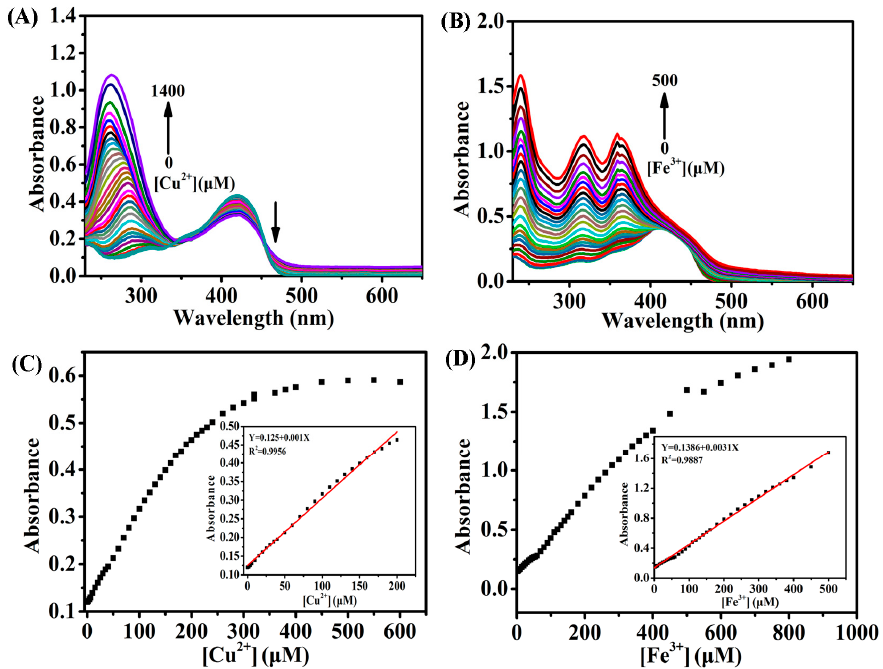
Figure 2. ( A ) UV–Vis absorption responses of PDBDBM sensor (1 × 10 − 5 g/mL) in THF upon addition of Cu 2+ ; ( B ) UV–Vis absorption responses of PDBDBM sensor (1 × 10 − 5 g/mL) in THF upon addition of Fe 3+ ; ( C ) Absorbance at 288 nm of PDBDBM sensor (1 × 10 − 5 g/mL) in THF versus the increasing concentration of Cu 2+ , the insert shows the plot of absorbance versus the concentration of Cu 2+ ; ( D ) Absorbance at 240 nm of PDBDBM sensor (1 × 10 − 5 g/mL) in THF versus the increasing concentrations of Fe 3+ , the insert shows the plot of absorbance versus the concentration of Fe 3+ .